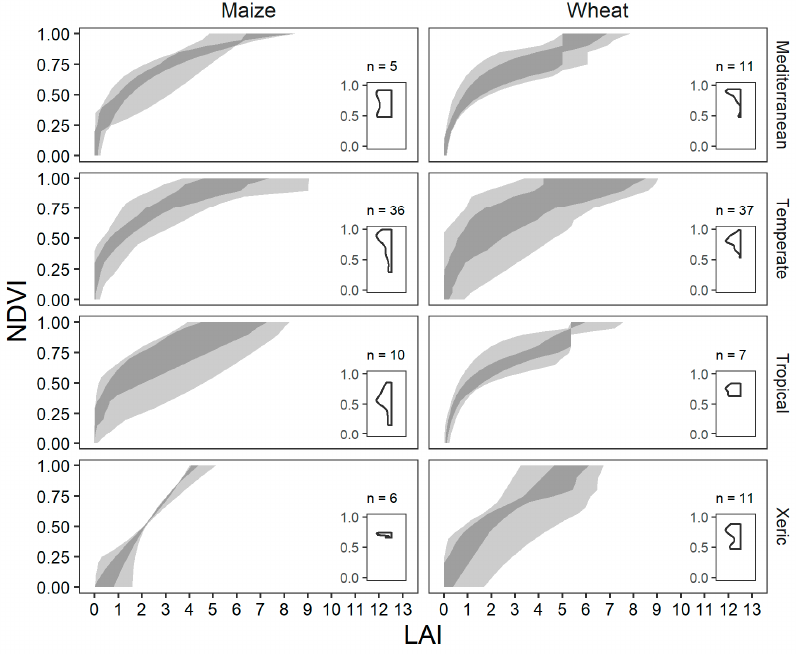
Figure 3. Correlation plots between the positive part of the normalized difference vegetation index (NDVI) existence range and leaf area index (LAI) for maize and wheat, sorted by biome. The grey shadows indicate the 5–95th (light grey) and the 25–75th percentile (dark grey) of the LAI values obtained from the equations considered. The half-violin plot shows the R 2 distribution; n is the number of